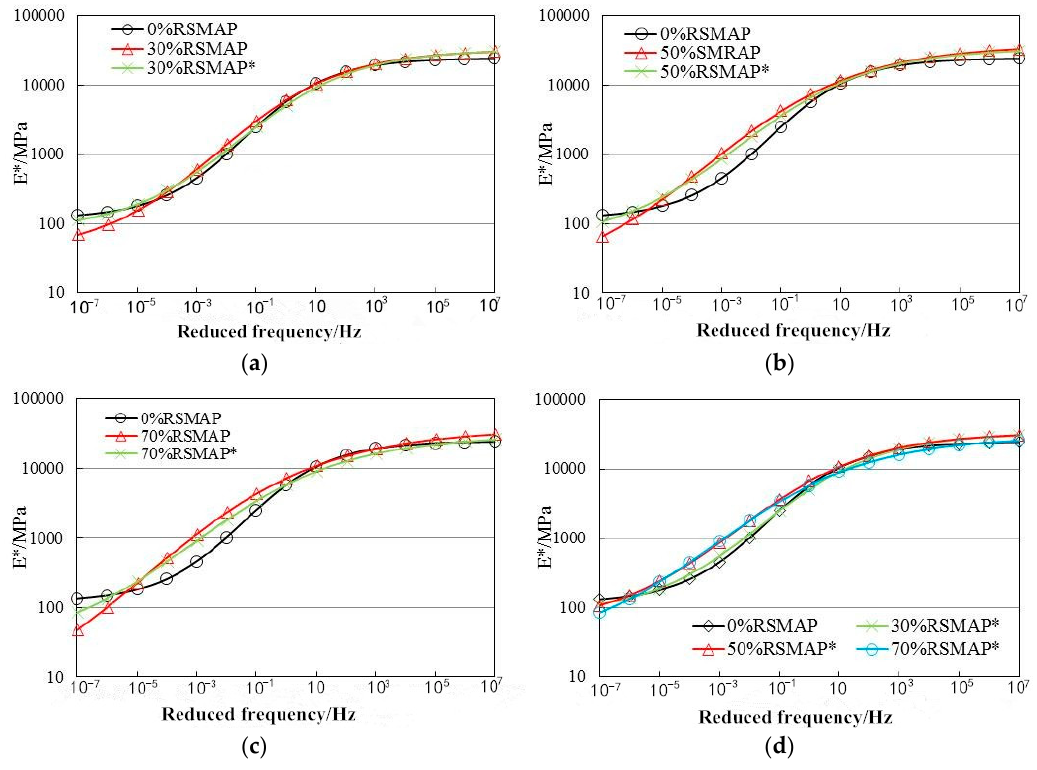
Figure 6. ( a ) Master curves of recycled mixtures with 30% RSMAP; ( b ) Master curves of recycled mixtures with 50% RSMAP; ( c ) Master curves of recycled mixtures with 70% RSMAP; ( d ) Master curves of recycled mixtures with all RSMAP contents.